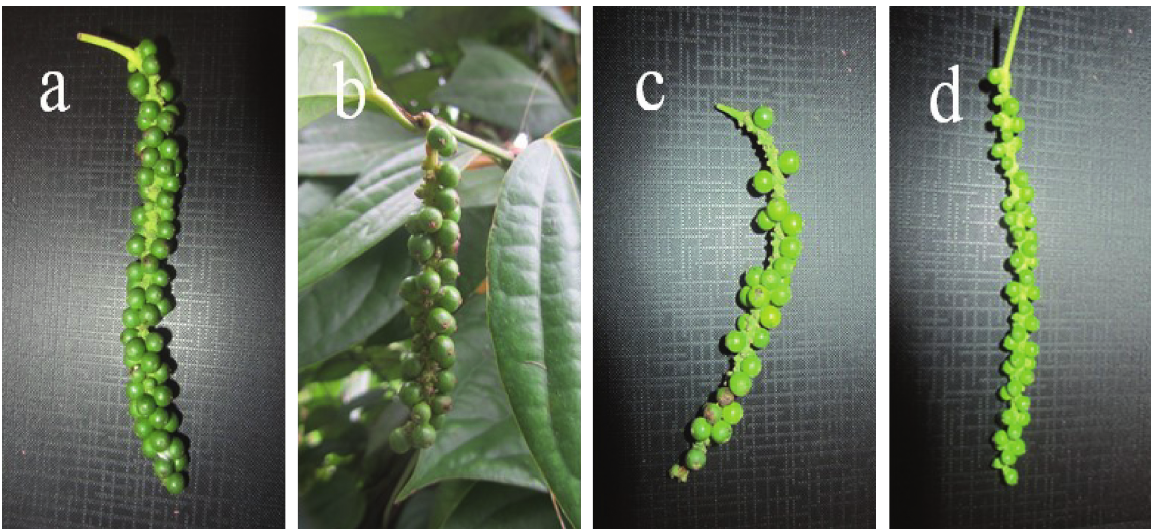
Figure 9: Berry set among pepper cultivars grown in the study area. (a) Ismailia. (b) Babu ndogo. (c) Babu kati. (d) Babu